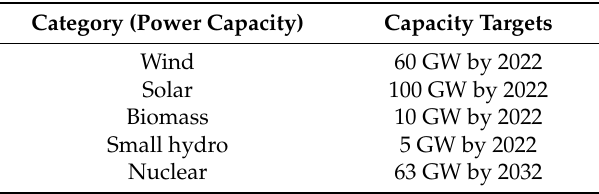
Table 2. Non-fossil-fuel-based capacity addition